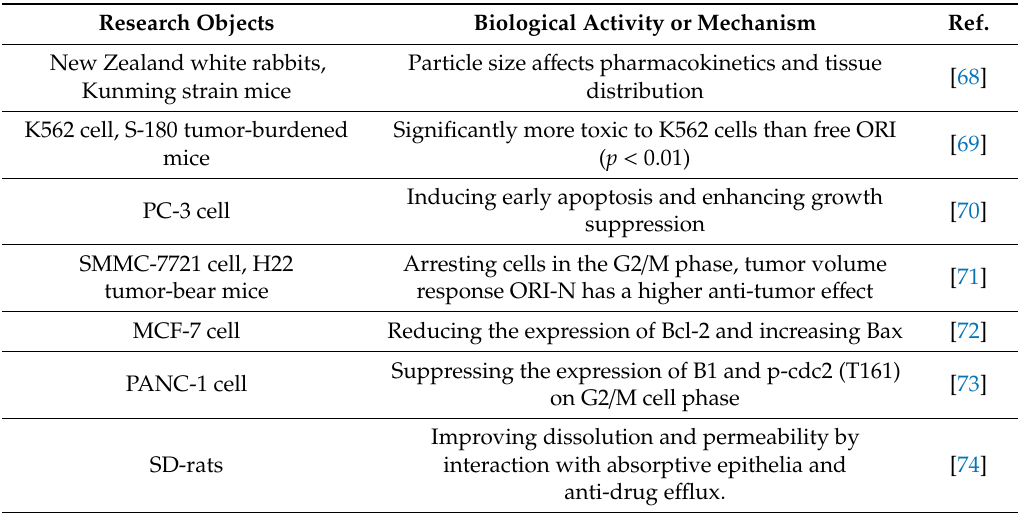
Table 2. Cytotoxicity and pharmacodynamics study of ORI